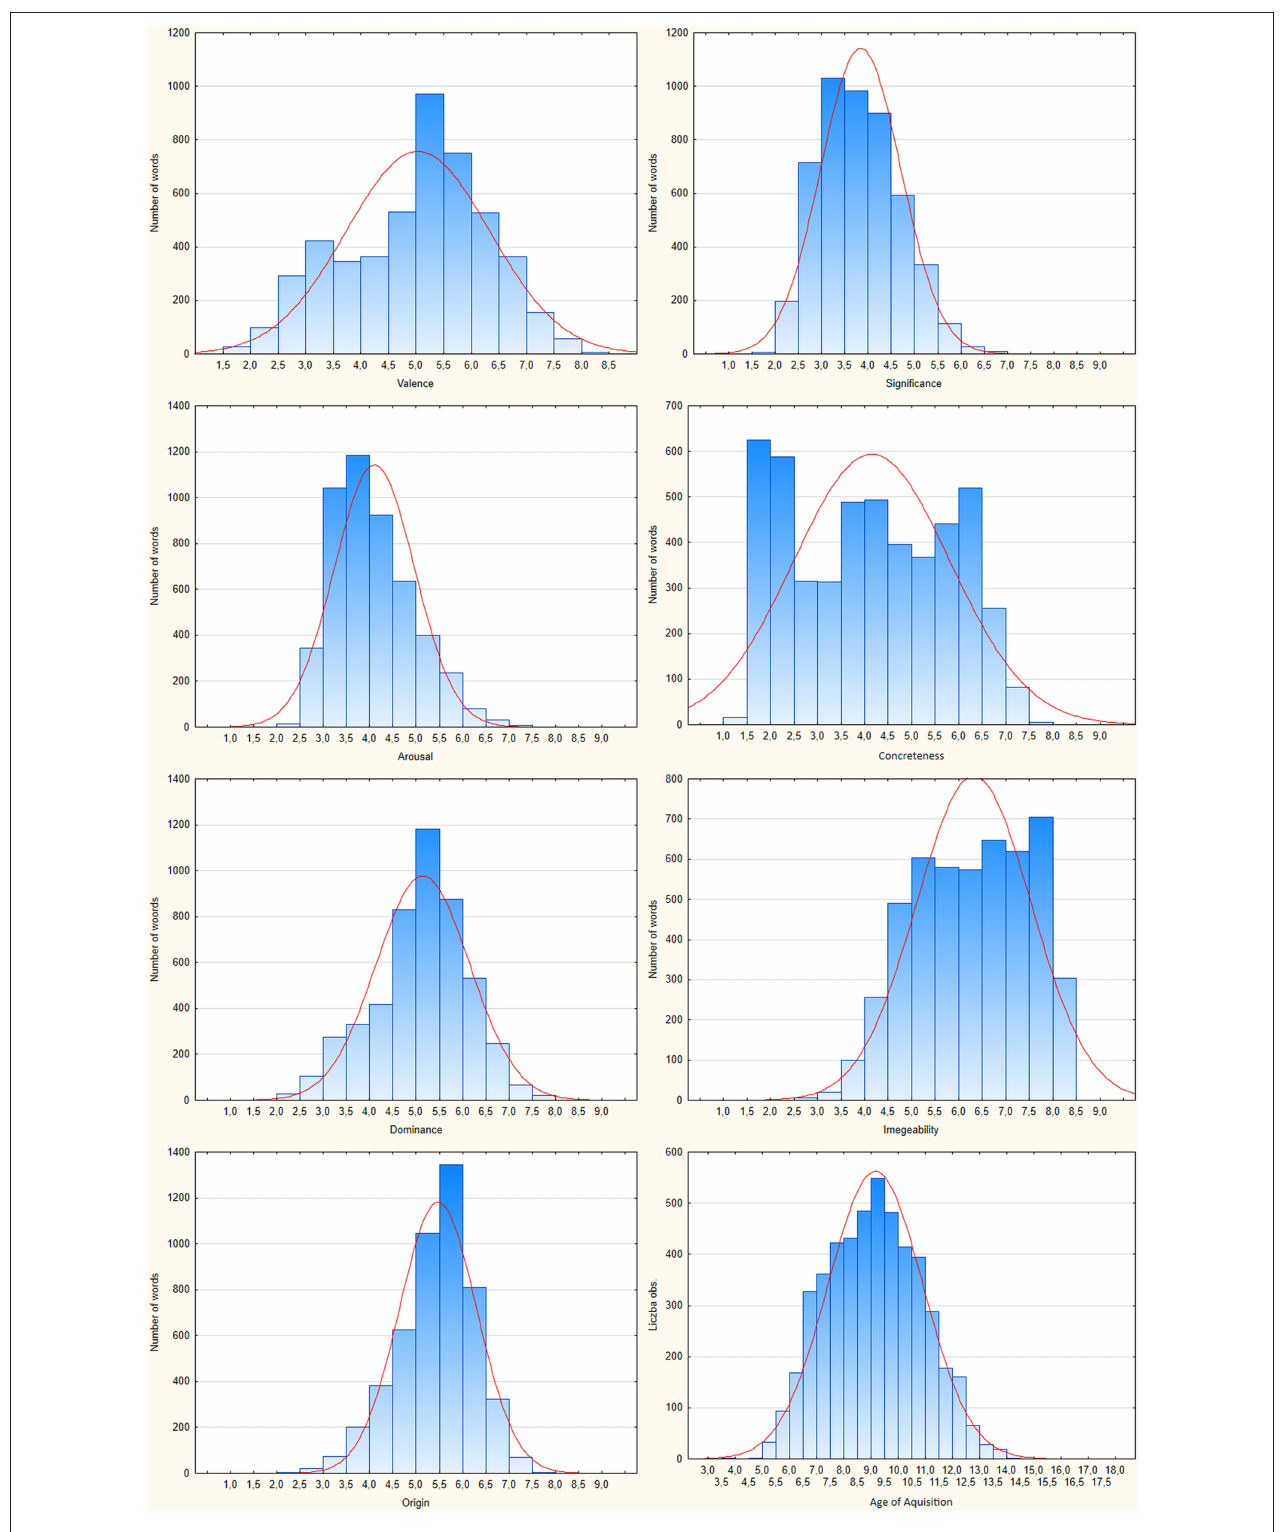
FIGURE 2 | Histograms presenting number of words assessed in 0.5 intervals from 1 to 9 of SAM scales.